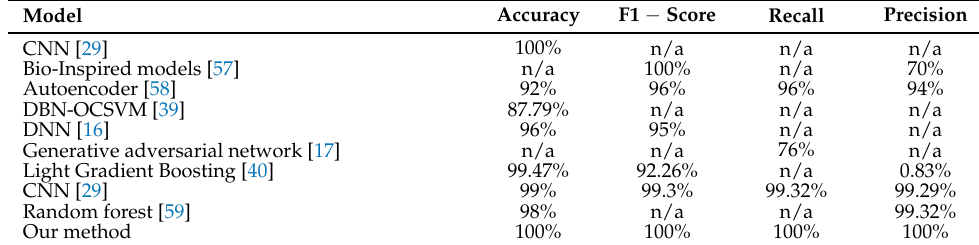
Table 8. Comparison with different classification